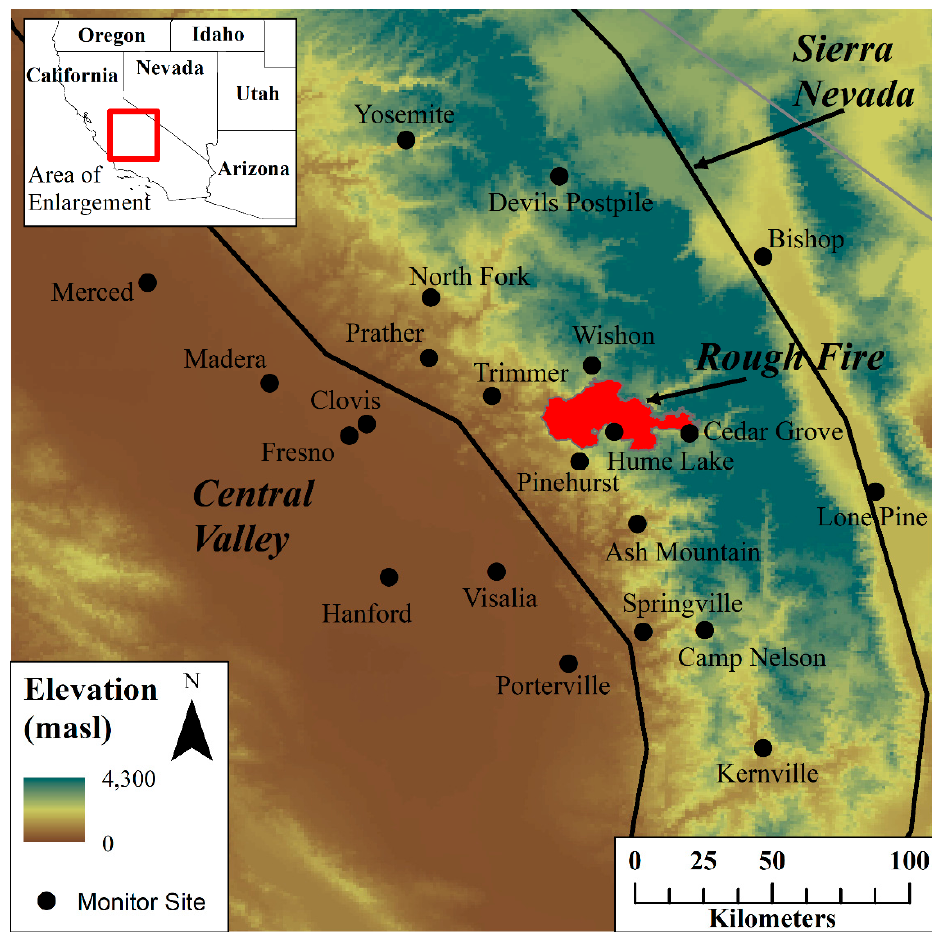
Figure 1. Location of study area and location of air quality monitors. Table 1. Distribution of 24-hr average PM 2.5 concentrations before (1 June–30 July 2015) and during (31 July–2 October 2015) the Rough Fire, arranged by region and distance to fire. N is the number of 24-hr average measurements at the location.